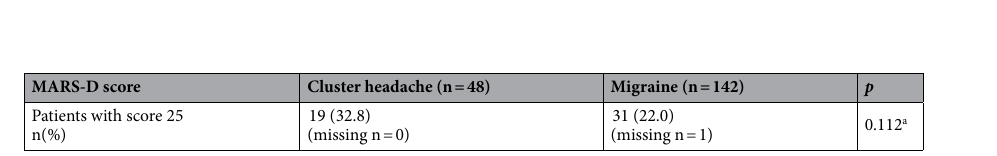
Table 4. Mean and standard deviation of individual MARS-D items and sum for both headache types. a Welch test.